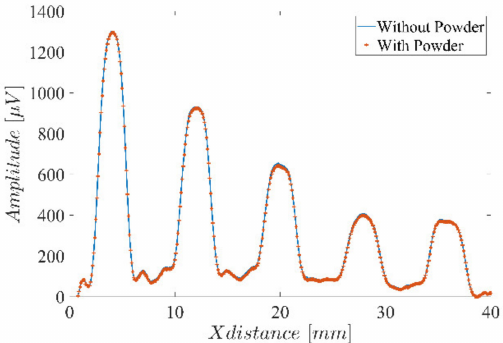
Figure 4. Single-coil probe amplitude response for the holes along Figure 1 L1, with and without the stainless steel 316 powder’s